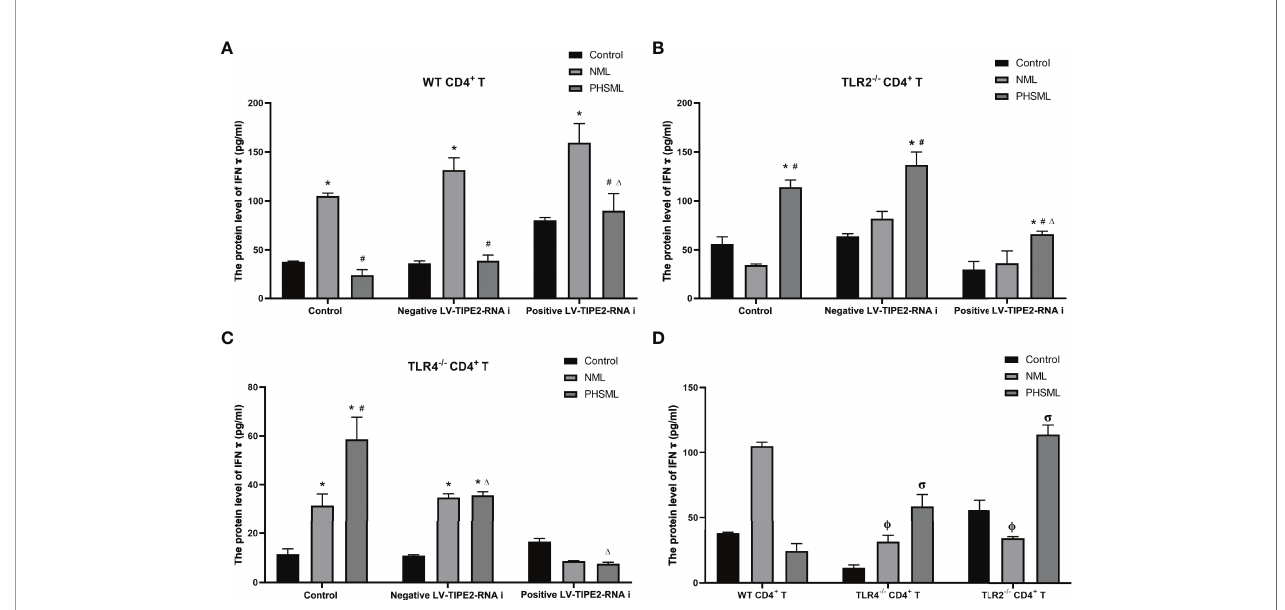
FIGURE 7 | The changes of IFN- g production in CD4 + T cells isolated from various mice. (A) The production of IFN- g in cultural supernatant of CD4 + T cells from WT mice infected with TIPE2 shRNA following by the stimulation of PHSML detected by ELISA; (B) The production of IFN- g in cultural supernatant of CD4 + T cells from TLR2 -/- mice infected withTIPE2 shRNA following by the stimulation with PHSML detected by ELISA; (C) The production of IFN- g in cultural supernatant of CD4 + T cells from TLR4 -/- mice infected with TIPE2 shRNA following by the stimulation with PHSML detected by ELISA; (D) The production of IFN- g in cultural supernatant of CD4 + T cells from WT, TLR2 -/- or TLR4 -/- mice stimulated with PHSML detected by ELISA, respectively. Data are expressed as the mean ± SE (n = 6). *P < 0.05 vs control treated control group, #P < 0.05 vs NML treated control group, D P < 0.05 vs PHSML treated control group, j P < 0.05 vs NML treated WT CD4 + T group, s P < 0.05 vs PHSML treated WT CD4 + T